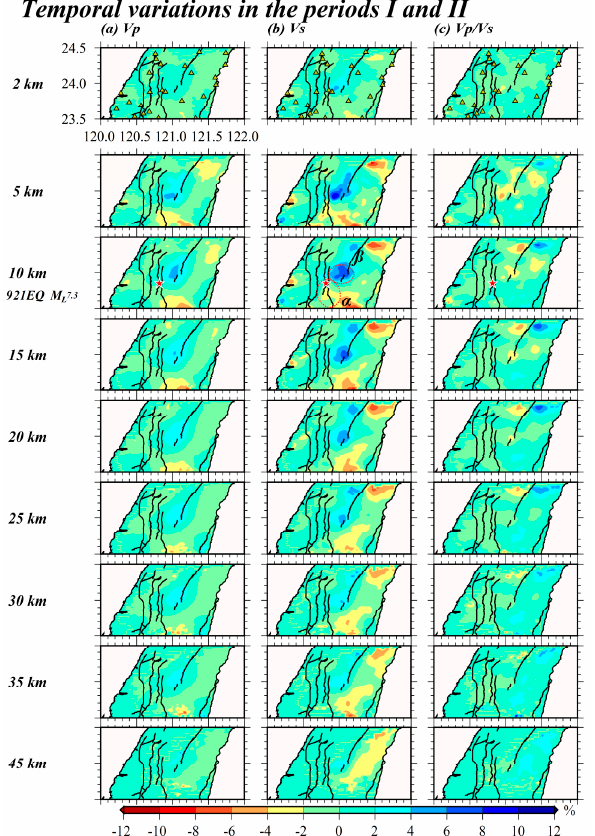
Figure 10. ( a ) Temporal variation in Vp in the periods I and II. ( b ) Temporal variation in Vs in the periods I and II. ( c ) Temporal variation in Vp/Vs in the periods I and II. See the detail description in the text.